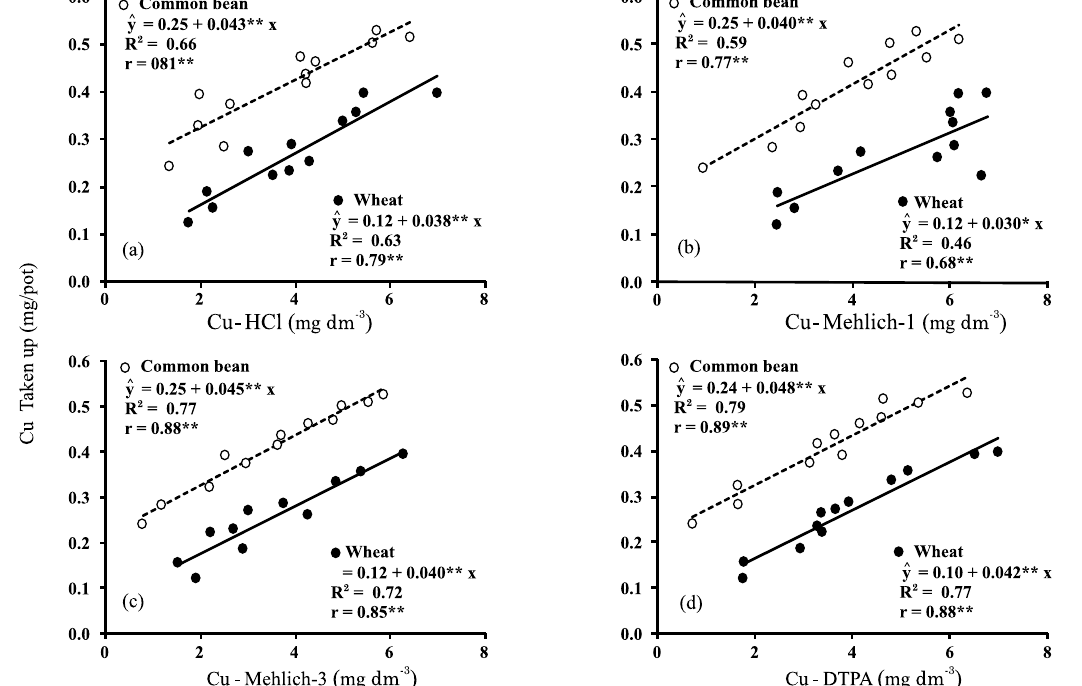
Figure 1. Relationship between the Cu contents extracted from the soil by HCl – (a), Mehlich-1 – (b), Mehlich- 3 – (c) and DTPA (d) and the quantity accumulated in wheat ( ) and common bean ( ) plants, in the first and second planting period, respectively. *: p < 0.05. **: p < 0.01. (n =